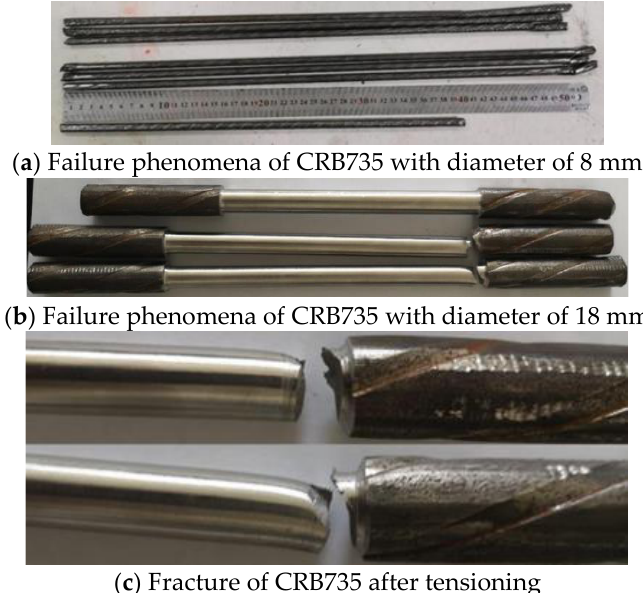
Figure 2. Failure phenomena of CRB735 used in this paper.